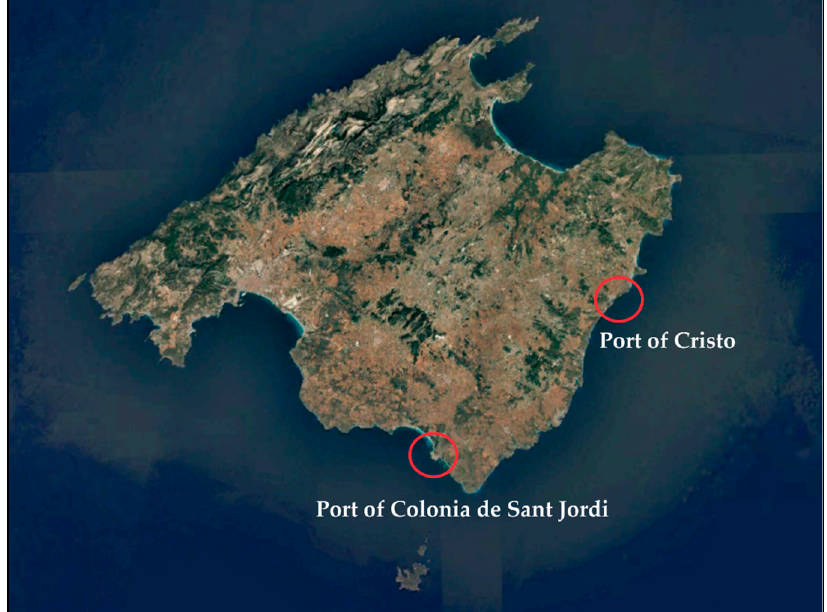
Figure 1. Mallorca island with two ports where the study was conducted. Source: Adapted by the authors, based on Google Earth map.